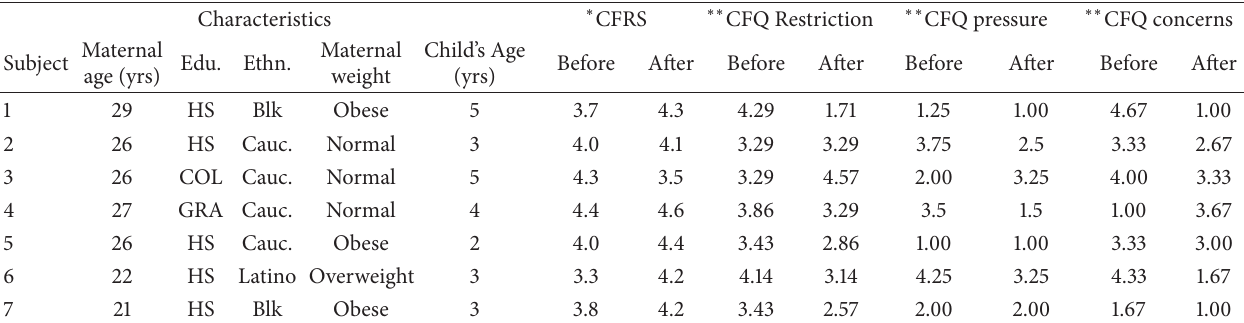
Table 4: Outcomes of the Feasibility of Feeding Dynamic Intervention (Study